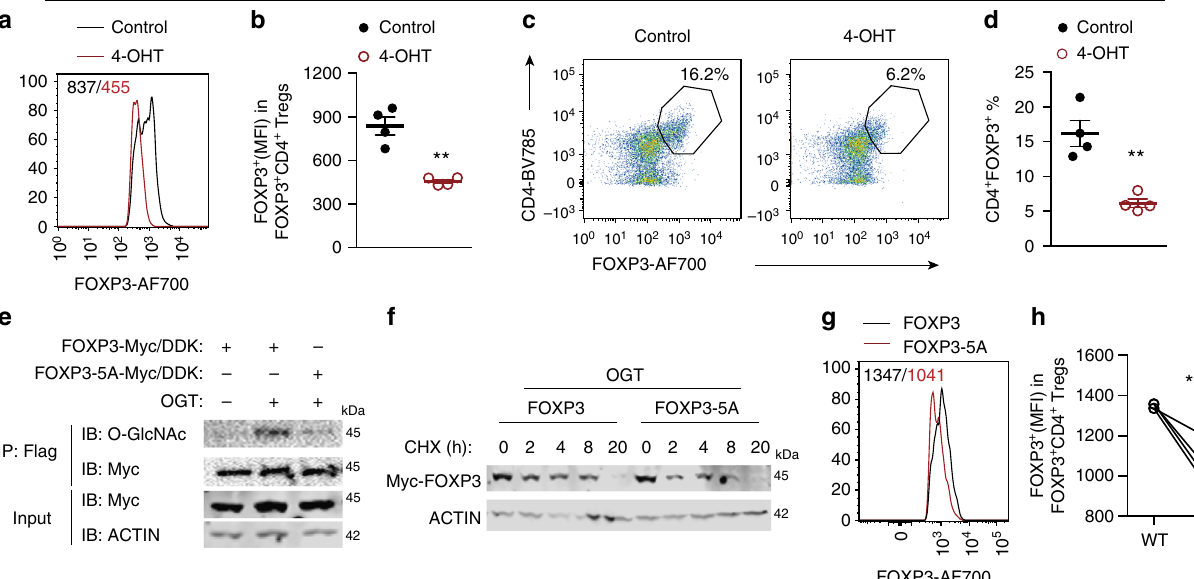
(Supplementary Fig. 5A) and progressive systemic in fl ammation in Foxp3 eGFP-Cre-ERT2/Y Ogt fl /Y Rosa26 tdTomato/wt mice (Supplemen- tary Fig. 5B-E). Gating on the CD4 + GITR + tdTomato + population, we found that more FOXP3 - tdTomato + ex-Treg cells emerged in